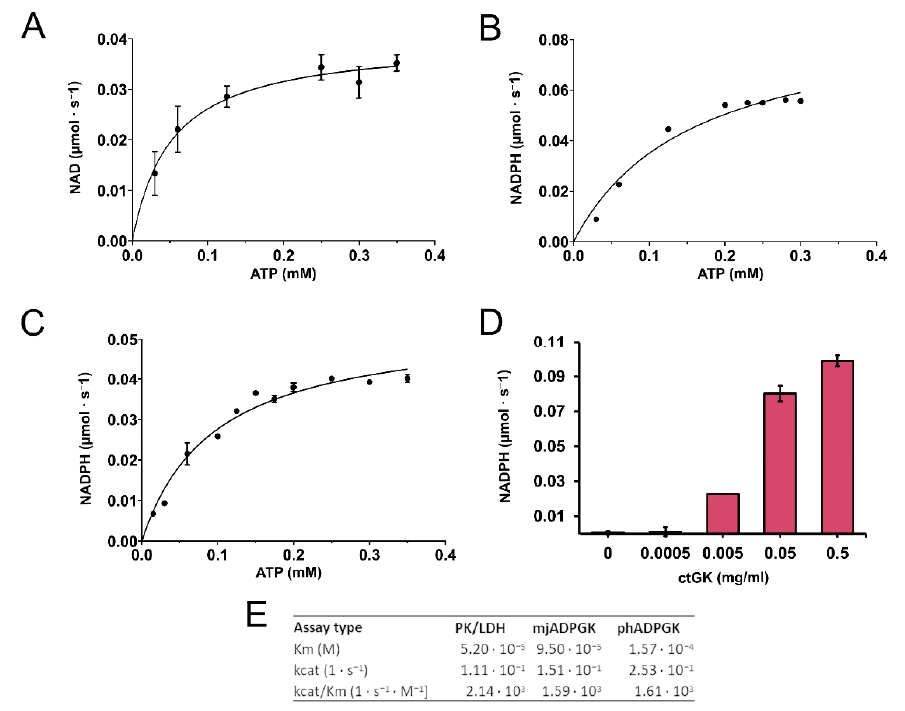
Figure 4. CtGK activity assay. ( A ) Reaction velocity as a function of ATP for CtGK in the PK / LDH-coupled assay, ( B ) phADPGK / G6PD-coupled assay, and ( C ) mjADPGK / G6PD-coupled assay. ( D ) Reaction velocity in the phADPGK / G6PD-coupled assay as a function of the CtGK concentration. ( E ) Kinetic parameters for CtGK-catalyzed reaction measured using different assays.